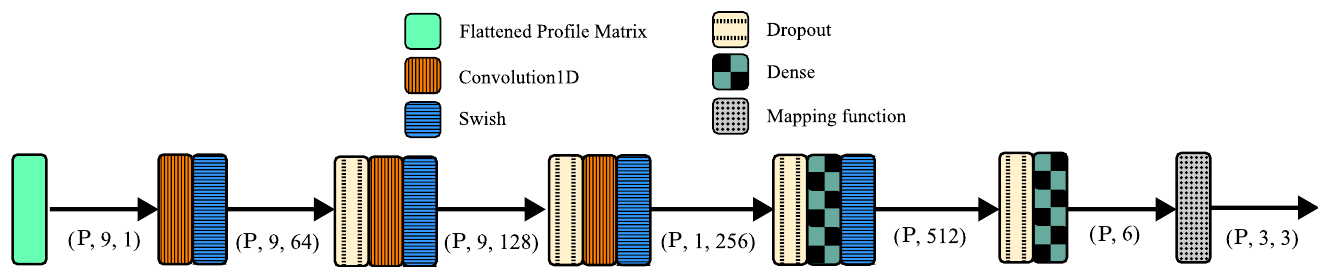
Figure 1. B-Swish (Modified